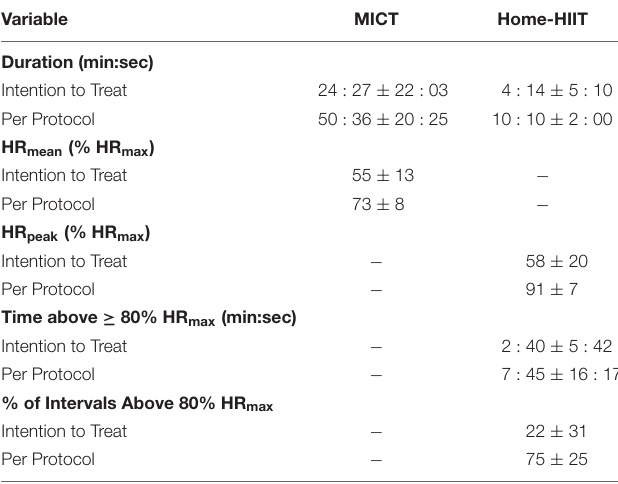
TABLE 5 | Mean training session duration and heart rate responses during 3-month intervention of MICT or Home-HIIT. Variable MICT Home-HIIT